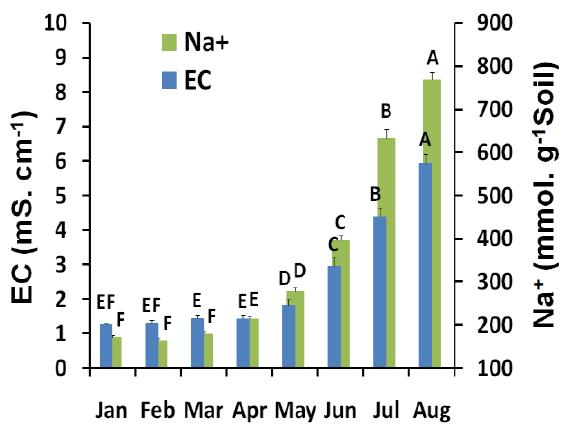
Figure 1. Monthly variations of the soil physicochemical parameters.